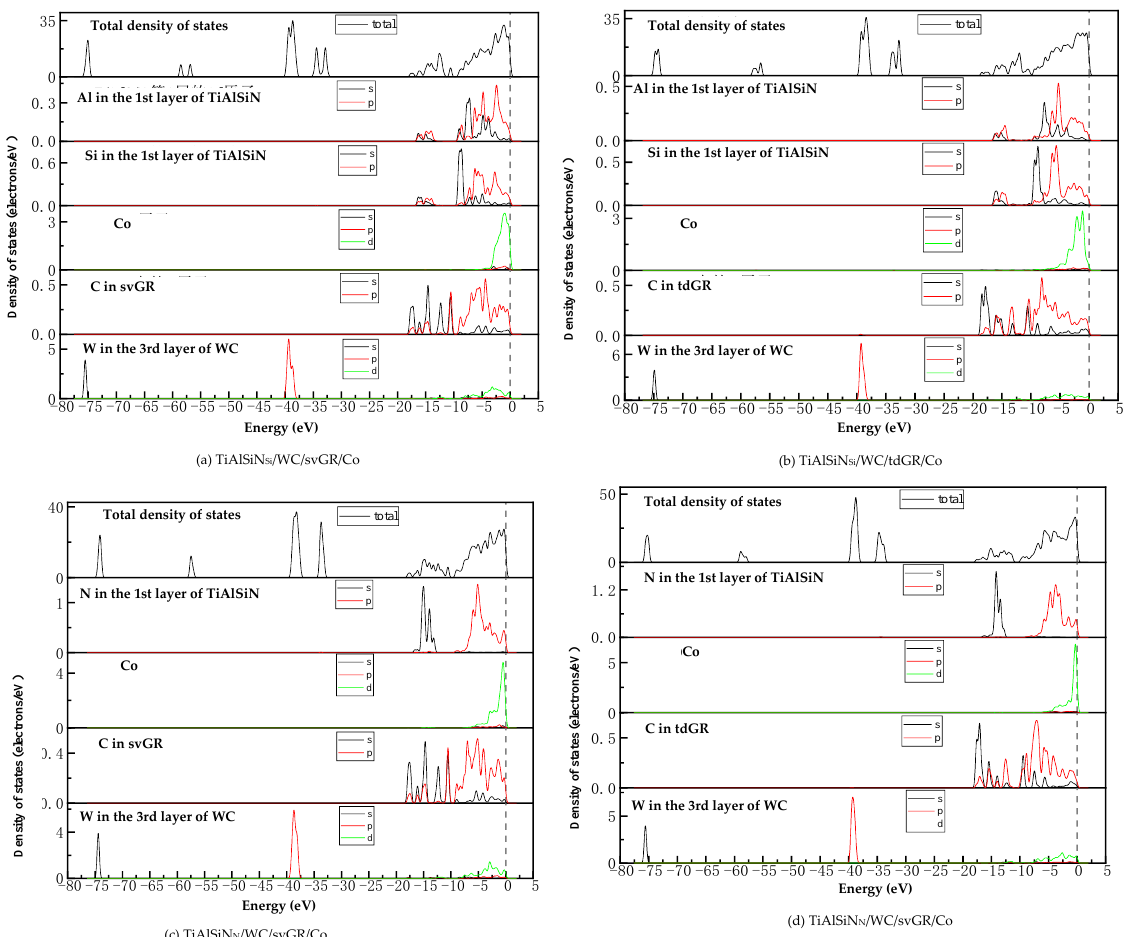
TiAlSiN/msGR/TiAlSiN Si /WC-Co, the charges between Al, Si, and Co atoms are rear- ranged, and at Fermi level, Al, Si, and Co atoms at the interface produce orbital hybridi- zation, forming covalent bonds. Compared with Figure 15a without graphene doping, the covalent effect is weak, which explains the essential mechanism that the adhesion work value of TiAlSiN/msGR/TiAlSiN Si /WC-Co is higher than that of TiAlSiN Si /WC-Co. In Figure 18b, in the model of TiAlSiN/msGR/TiAlSiN N /WC-Co, N-s and C-s produce orbital hybridization in the range −2 2~15 eV, and N-p and C-p produce orbital hybridi- zation in the range −1 0~3 eV, forming N/C bonds. Al-s, Al-p and C-s, and C-p produce orbital hybridization in the range −1 7~3 eV, forming Al/C bonds. N-p and Co-d produce orbital hybridization in the range −5 ~3 eV, forming N/Co bonds. The density of atomic states of forming chemical bonds and orbital hybridization degree is high, which explains the essential mechanism that the adhesion work of TiAlSiN/msGR/TiAlSiN N /WC-Co is greater than that of TiAlSiN N /WC-Co. Figure 18. TDOS and PDOS of the interface models with the coating doped with msGR.